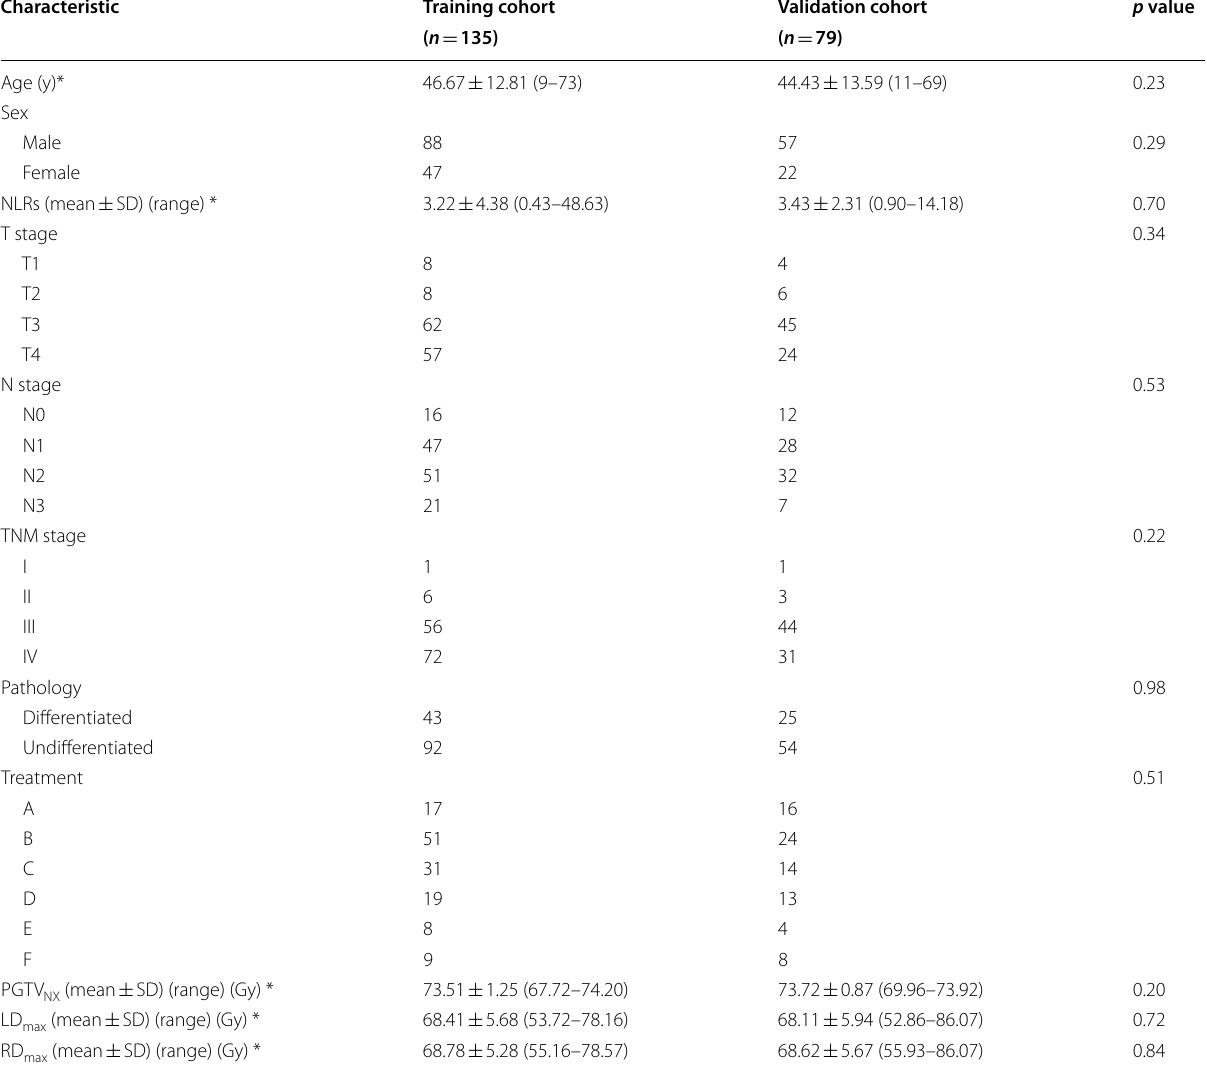
Table 1 Characteristics of patients in the training and validation